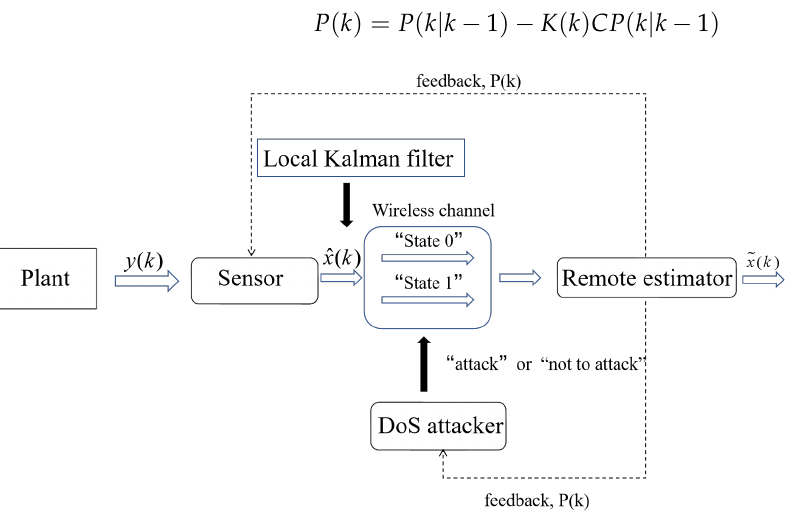
Figure 1. Secure state estimation process of CPS against DoS attack.